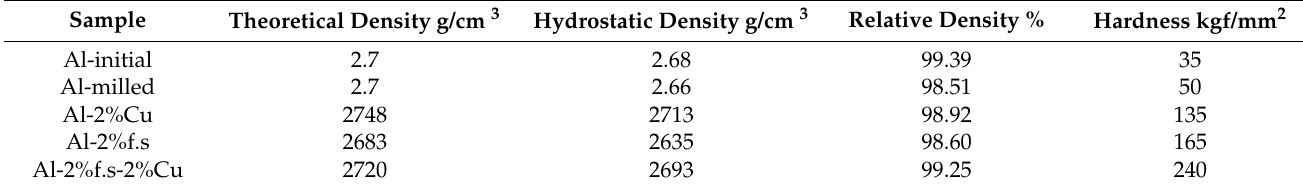
Table 1. Density and hardness of the compact composites.